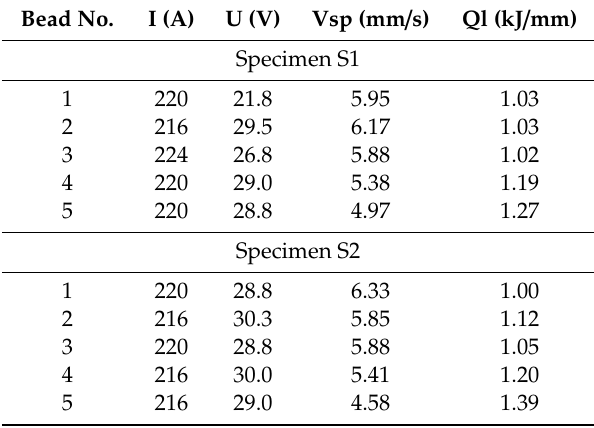
Figure 2. Scheme of welding process in ( a ) specimen S1 and ( b ) specimen S2. Table 3. Welding parameters for specimens S1 and S2. Bead No.